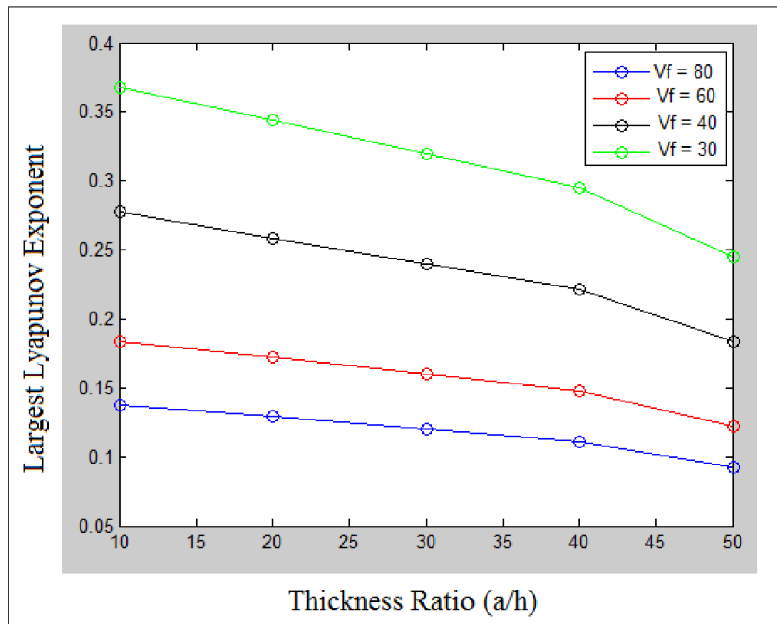
Figure 10. Largest Lyapunov exponent against thickness ratio for plate with one stiffener.